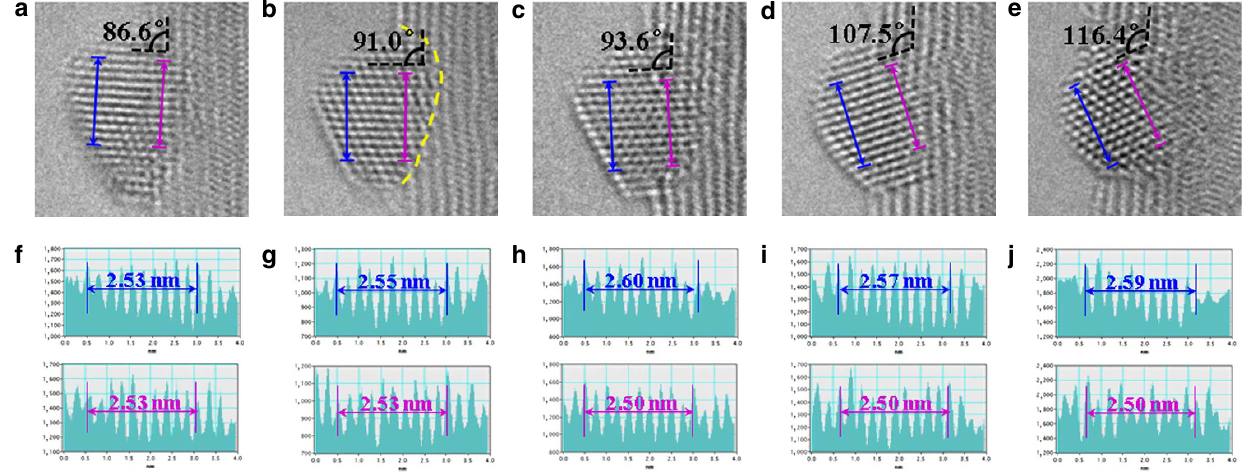
Figure 3 | Measurement of the change in lattice spacing induced by oxygen concentration gradient. ( a – e ) are enlarged images taken from Fig. 2; ( f – j ) are the measured d spacing of the outside and inner 10 interplanar spacing. The two black dashed lines marked the angle between the NP and the CNT, where the blue and pink double-head arrows marked the 10 outside ( d o ) and inner ( d I ) interplanar spacing within the